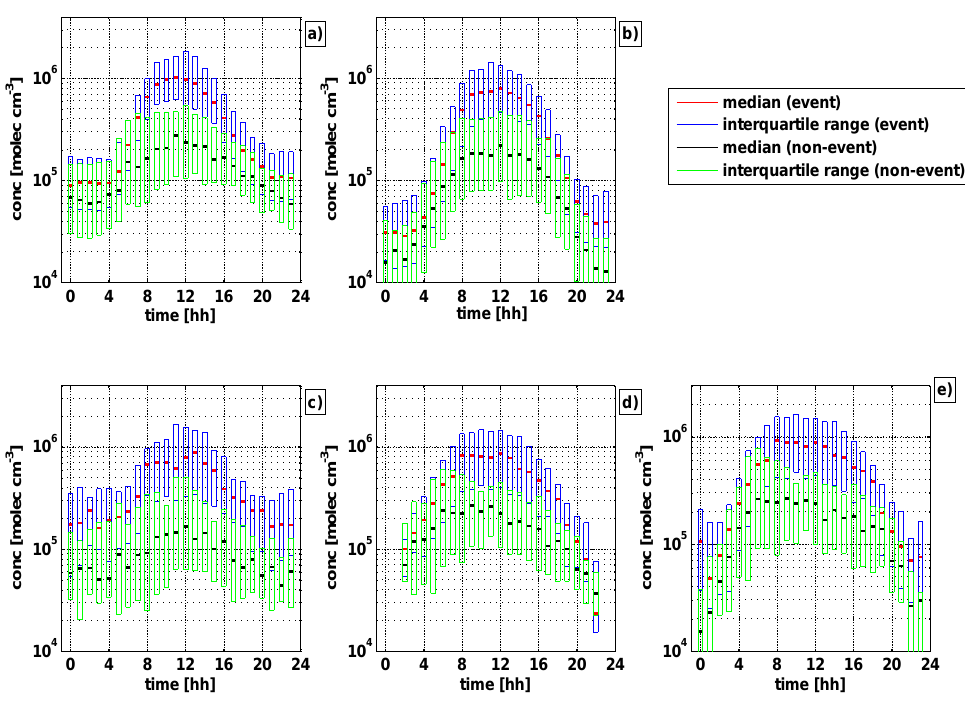
Fig. 6. Median diurnal cycle of (a) measured, (b) modeled, and (c)–(e) proxy calculated sulfuric acid during all measurement days during the EUCAARI field campaign in Hyyti¨al¨a and after grouping the days into two classes with and without new particle formation. Bar height describes interquartile range (25%–75%) of the concentrations.